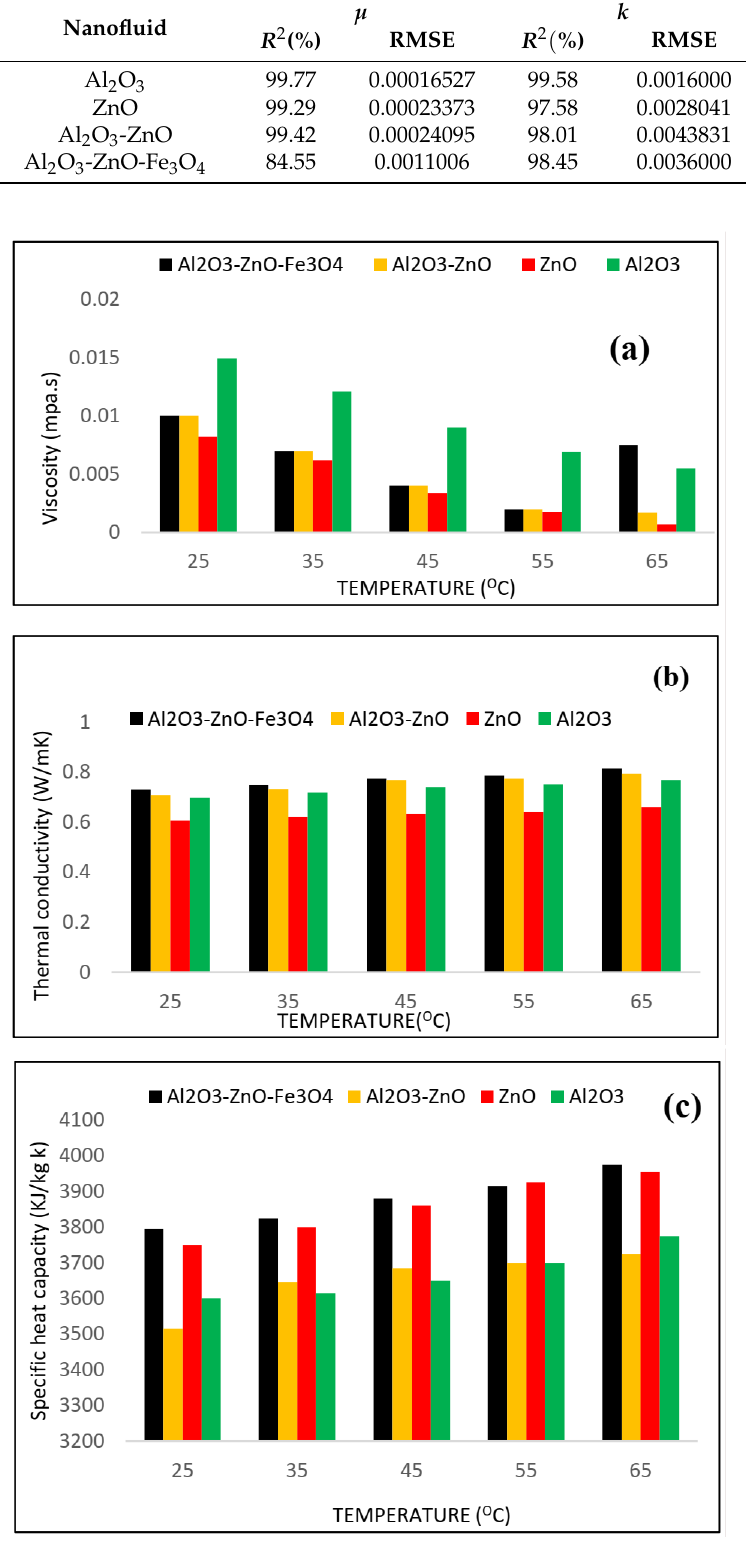
Figure 5. Properties of Al 2 O 3 -ZnO-Fe 3 O 4 , Al 2 O 3 -ZnO, ZnO, Al 2 O 3 Nanofluids ( a ) Viscosity ( b ) Thermal conductivity ( c ) Specific heat